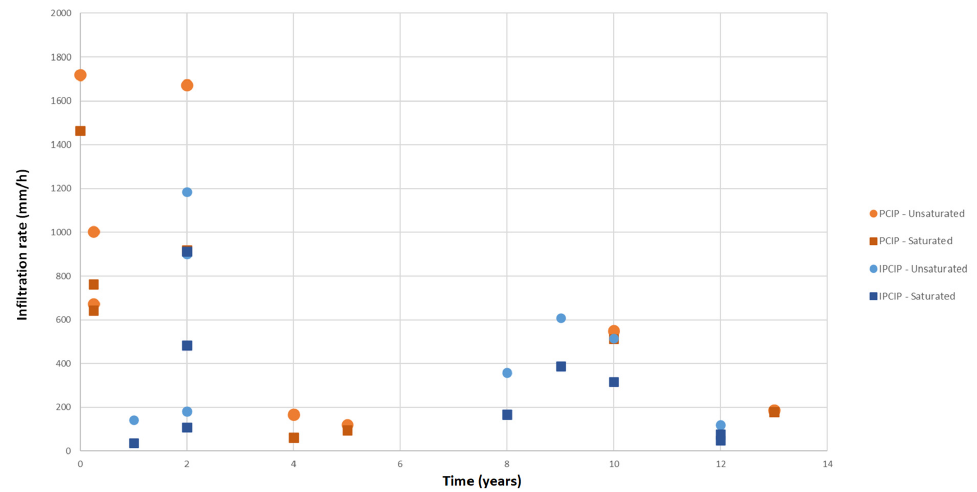
Figure 4. Infiltration rate of PCIP (orange, red) and IPCIP (light, dark blue) systems under unsaturated Saturation effects differ between PCIP and IPCIP. Whilst saturation decreases the in- filtration rate of PCIP by 22.9% on average (median: 17.9%), for IPCIP, an average decrease (circles) and saturated (squares) in infiltration rates of 45.1% due to saturation was found (median: 40.7%). An explanation